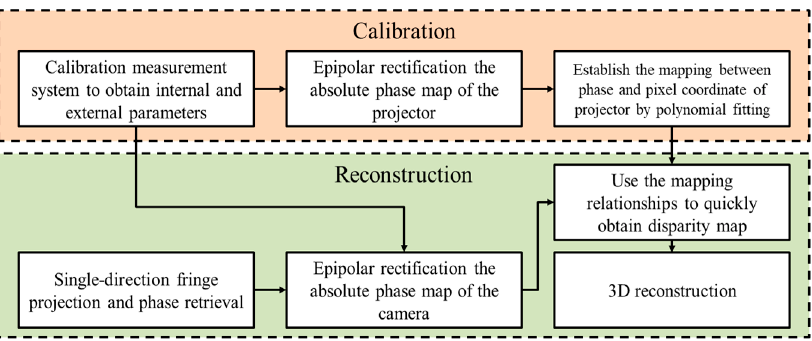
Figure 5. The overall flow chart of the proposed method.